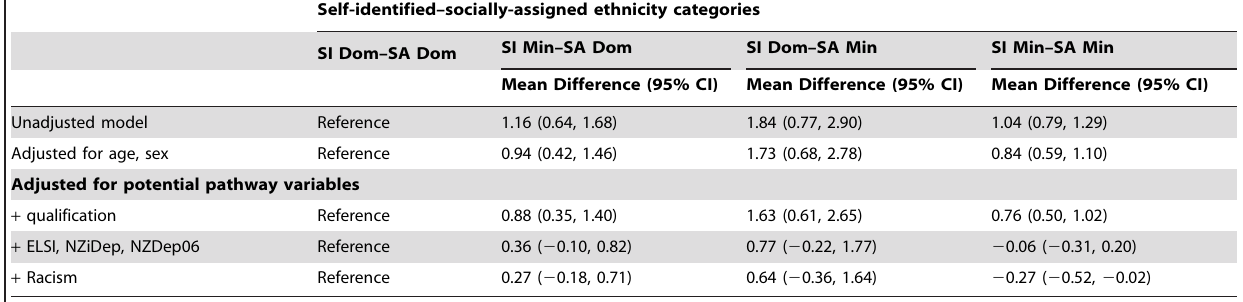
Self-identified–socially-assigned ethnicity